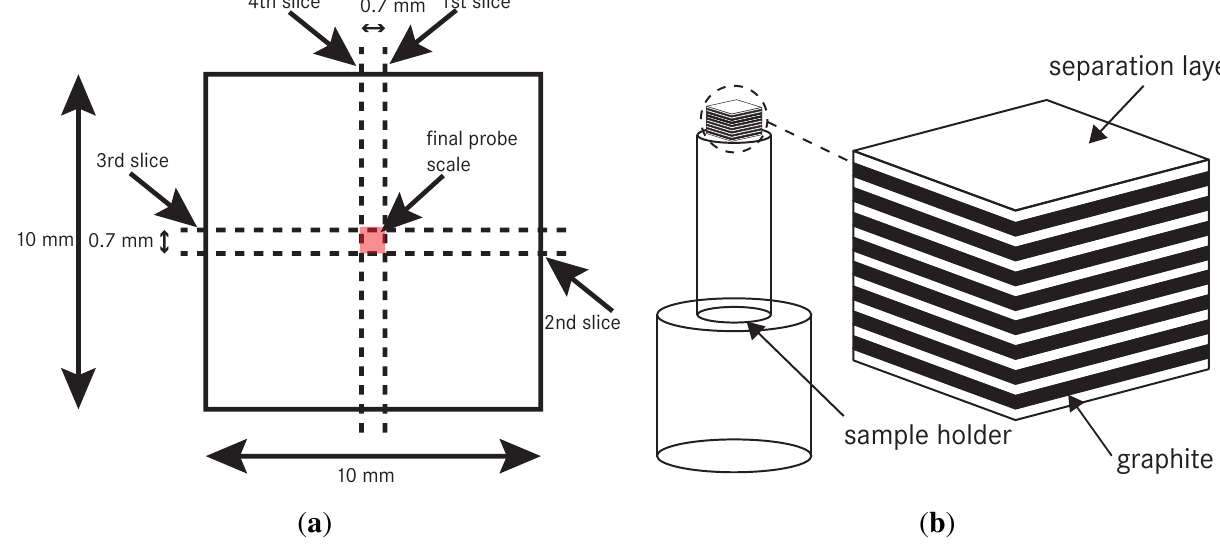
Figure 5. ( a ) The necessary cuts of the stacked probe to realize the final geometrics; ( b ) the final preparation setup.